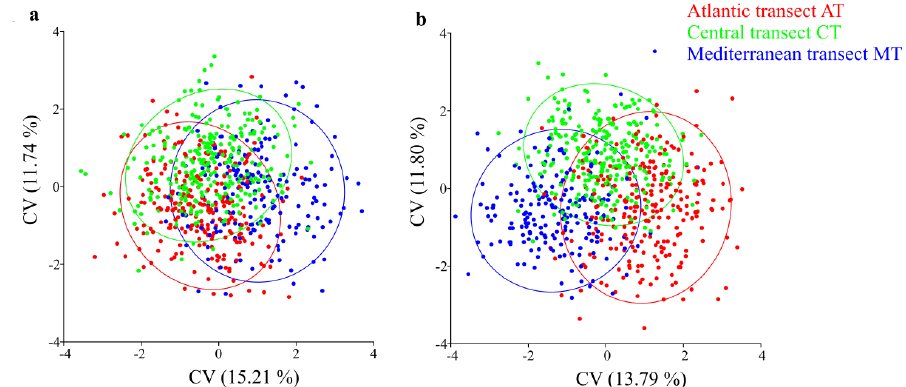
Figure 3. Scatterplots of individual scores from the canonical variant (CVA) analysis of ( a ) drone and ( b ) worker wing landmarks of the Iberian honey bee. Each dot represents a colony.